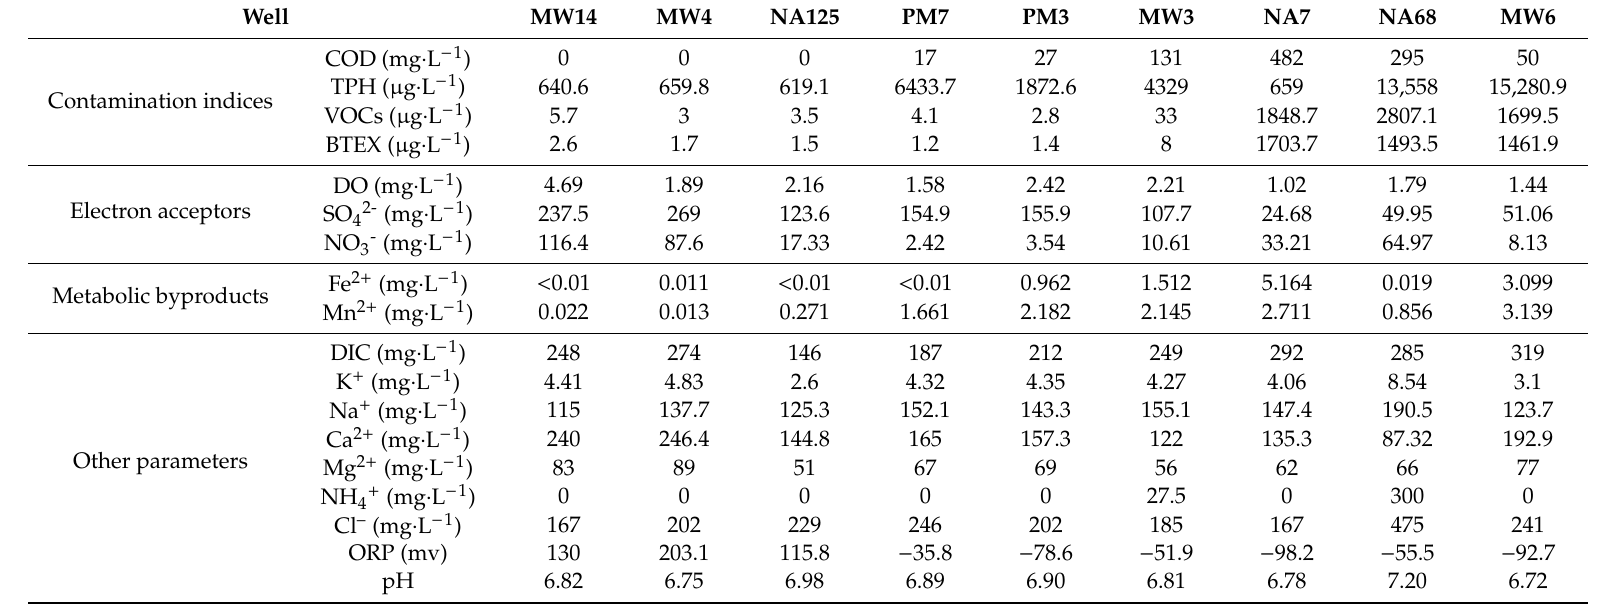
Table 1. Hydrochemical parameters of groundwater samples. COD, chemical oxygen demand; TPH, total petroleum hydrocarbons; VOC, volatile organic compound; BTEX, benzene, toluene, ethylbenzene, m-xylene, p-xylene, and o-xylene; DO, dissolved oxygen; DIC, dissolved inorganic carbon; ORP, oxidation-reduction